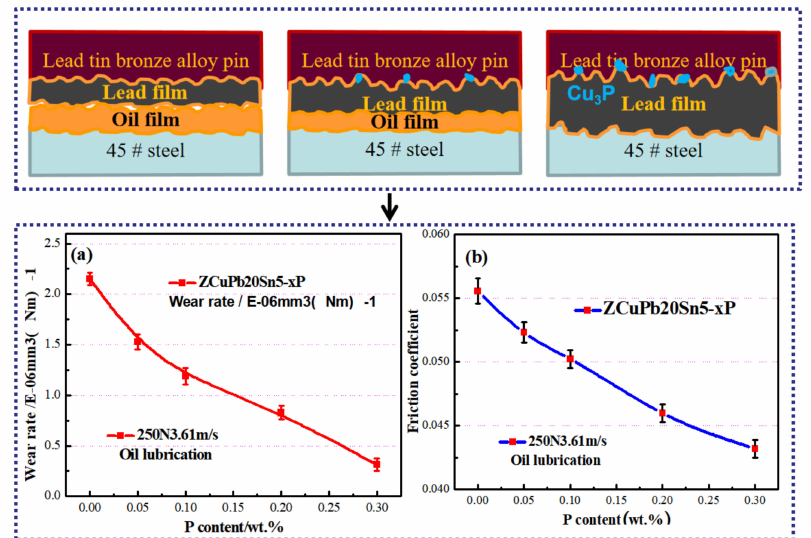
Figure 10. Mechanism diagram of friction and wear; ( a ) the relationship between the wear rate and P content under oil lubrication; ( b ) the relationship between the friction coefficient and P content under oil